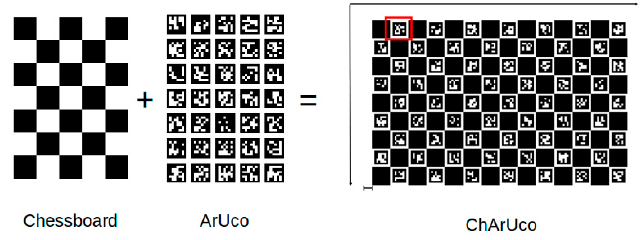
Figure 4. Design and parameters of the ChArUco board OpenCV.